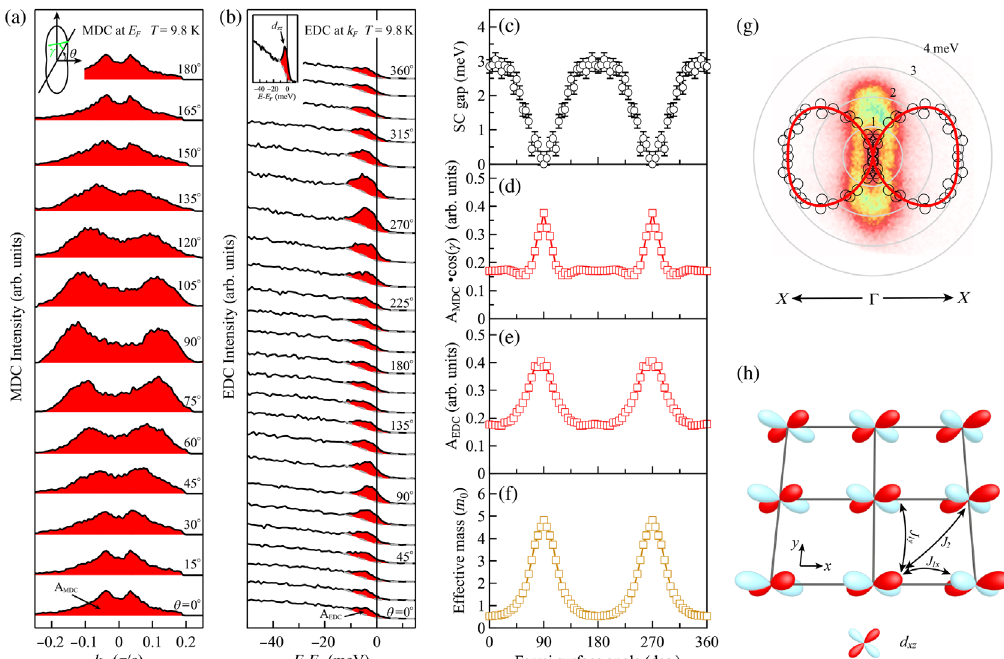
FIG. 4. Correlation between the superconducting gap, the spectral weight, and the effective mass of bands along the Fermi surface of FeSe. (a) Momentum distribution curves (MDCs) along different momentum cuts at the Fermi level measured at 9.8 K. The momentum cut is defined by the Fermi surface angle θ as shown in the inset. For a given Fermi momentum on the Fermi surface, the angle between the momentum cut and the Fermi surface normal direction is defined as an angle γ . The area of the MDCs marked in red is defined as the spectral weight A in (d). (b) Photoemission spectra (EDCs) of FeSe along the Fermi surface measured at 9.8 K. After subtracting the MDC Shirley background (dashed line), the area of the EDCs marked in red is defined as the spectral weight A of comparison, the superconducting gap measured at 1.6 K is replotted in (c). (d) MDC spectral weight along the Fermi surface obtained from (a) after considering the correction of the γ angle as defined in inset of (a). (e) EDC spectral weight along the Fermi surface obtained from (b). (f) Effective mass of the d xz band along different momentum cuts as obtained by a parabolic fitting of the α band in Fig. 3(b). (g) Superconducting gap plotted in the polar graph, overlaid with the measured Fermi surface in order to have a direct comparison of their relative orientations. (h) A schematic picture of the d xz orbitals in the Fe plane in the nematic state of FeSe. For the d xz orbitals, the dominant intraorbital coupling is the exchange interactions along the antiferromagneticlike while the J 1 x coupling is ferromagnetic in iron chalcogenides [44 –